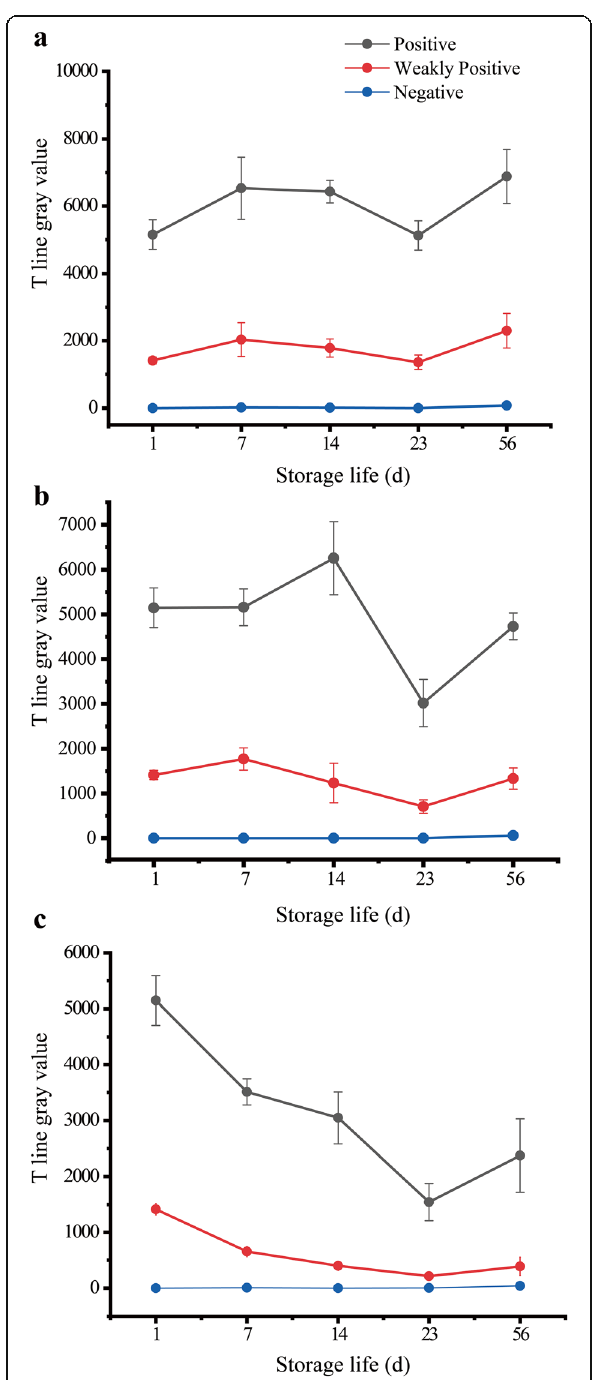
Fig. 6 Gray values of T line for the detection of high and low PEDV concentrations and the negative control over time. a Room temperature b 37 °C c 50